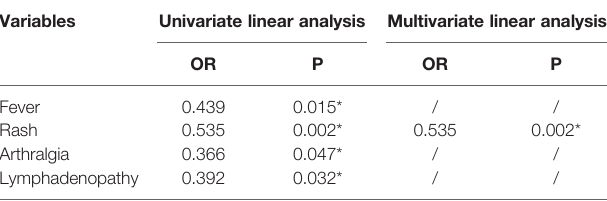
TABLE 3 | Univariate and multivariate linear analysis of clinical disease manifestations in AOSD. Variables